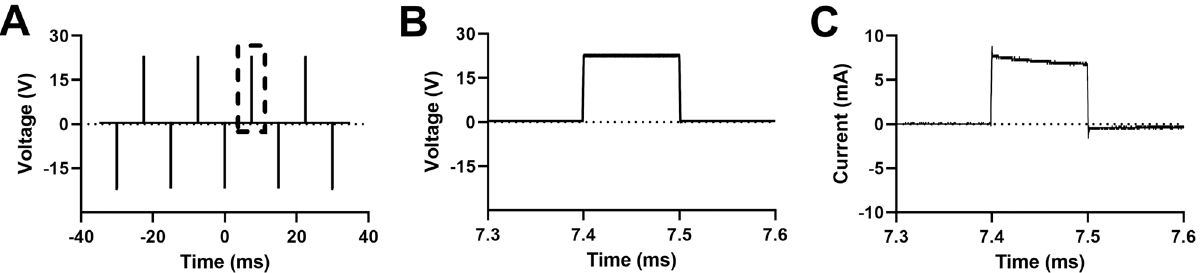
Figure 2. Time-averaged oscilloscope traces displaying the time varying voltage and current measured by the oscilloscope. ( A ) Multiple cycles of the voltage channel of a bipolar rectangular waveform with f = 66 Hz, V = 23 V, and t = 100 µs. The dotted box depicts a zoomed time region of the waveform with corresponding ( B ) voltage across the channel and ( C ) current through the channel. Time averaging: 64